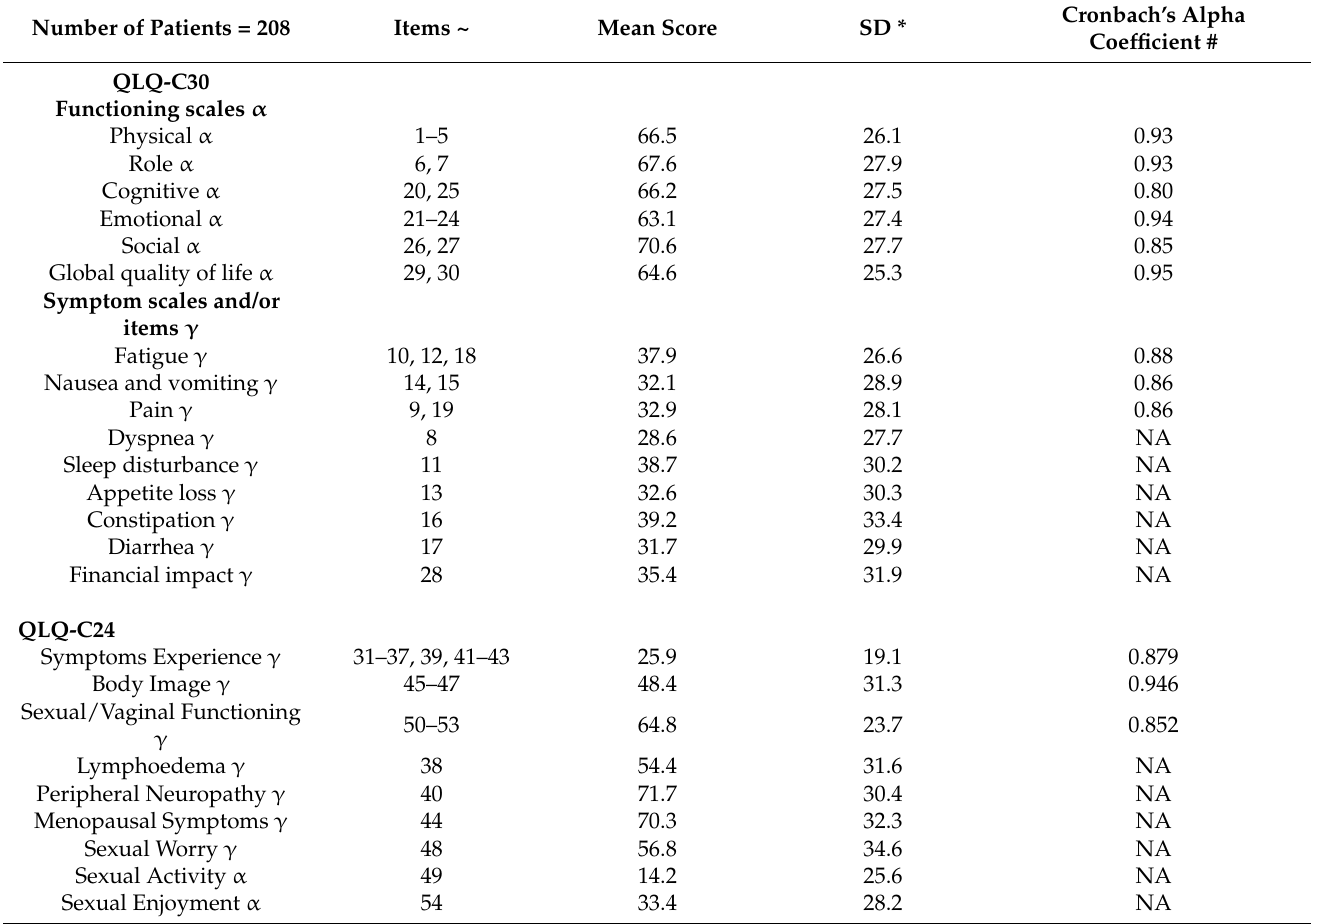
Table 3. The QoL of the 208 patients who answered the EORTC QLQ-C30 and EORTC QLQ-CX24.